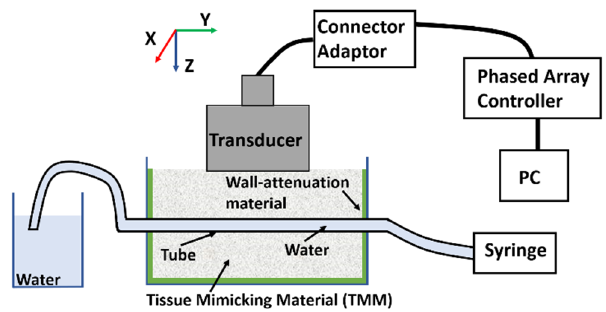
Figure 14. Illustration of the experimental setup for imaging the lab phantom using the CECAT.